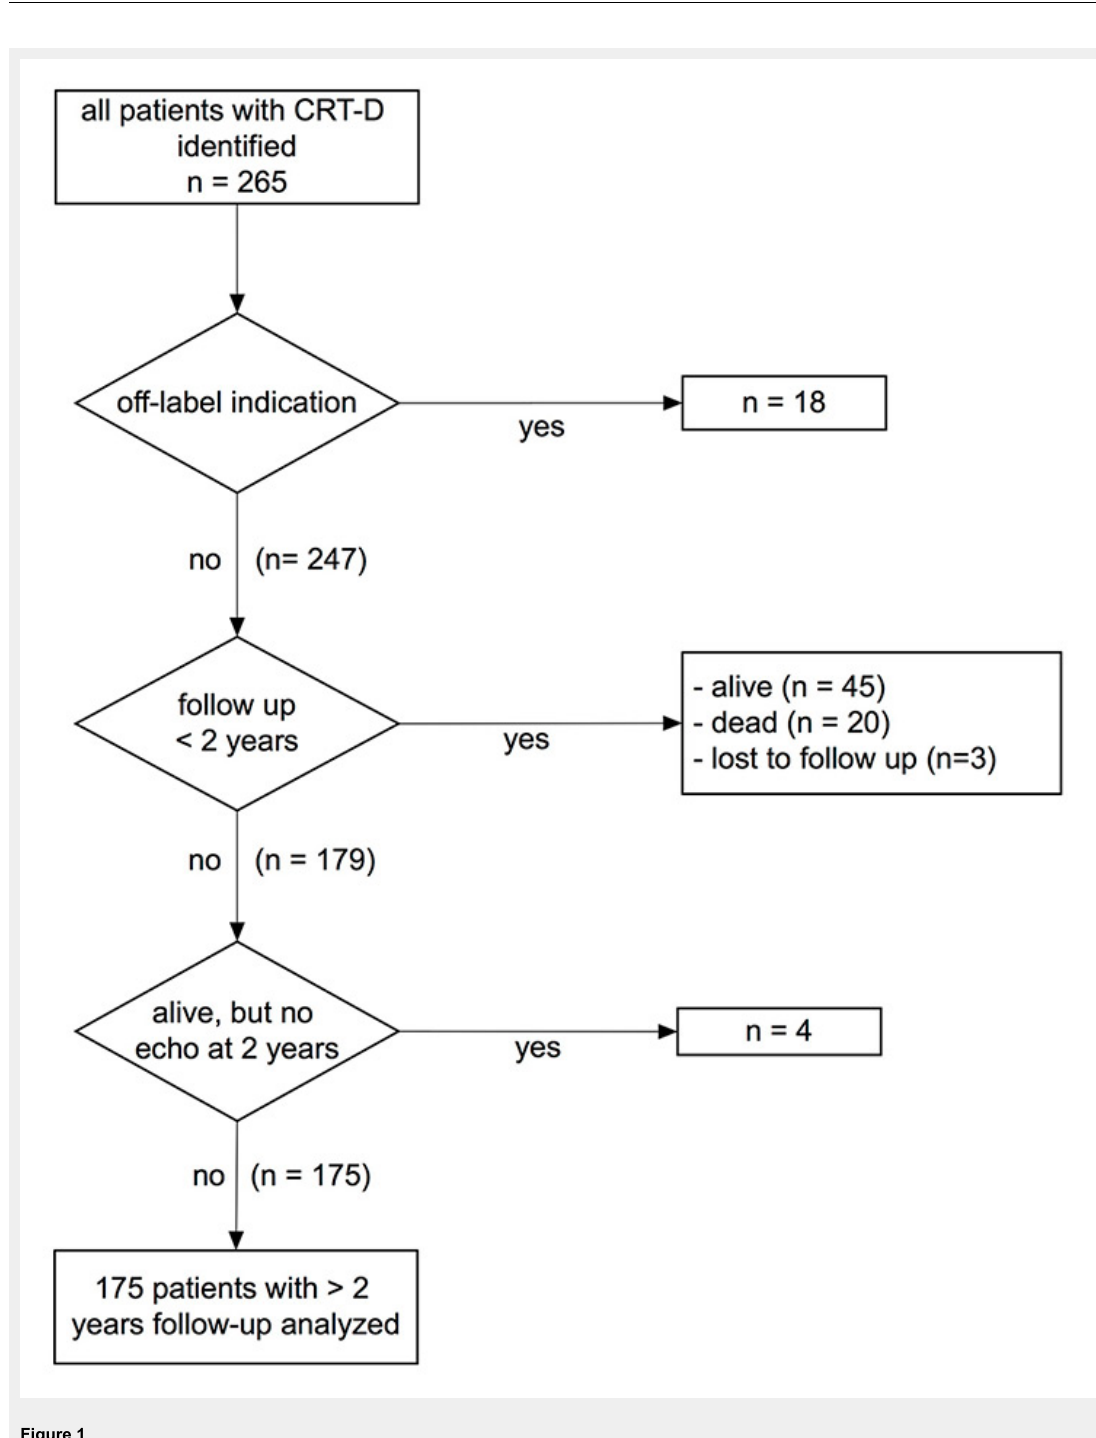
Figure 1 Flow-chart of all patients with a cardiac resynchronisation therapy with defibrillator back-up device (CRT-D) implanted at our